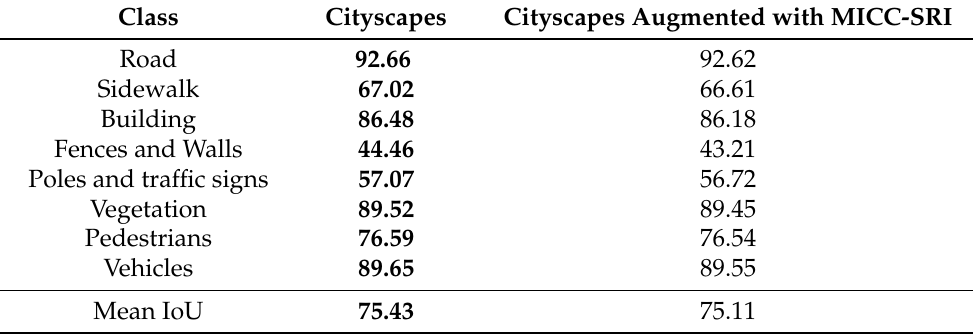
Table 3. Semantic segmentation (IoU) with MobileNetV2 on Cityscapes dataset and Cityscapes dataset augmented with MICC-SRI dataset.